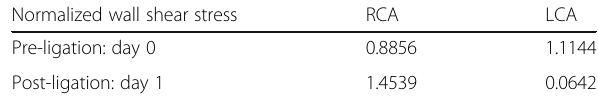
Table 3 Normalized wall shear stresses before and after ligation in the middle portions of the carotid arteries Normalized wall shear